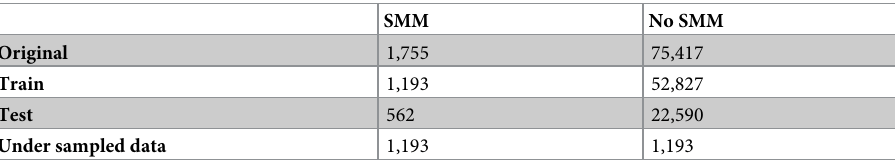
Table 2. Number of SMMs in different